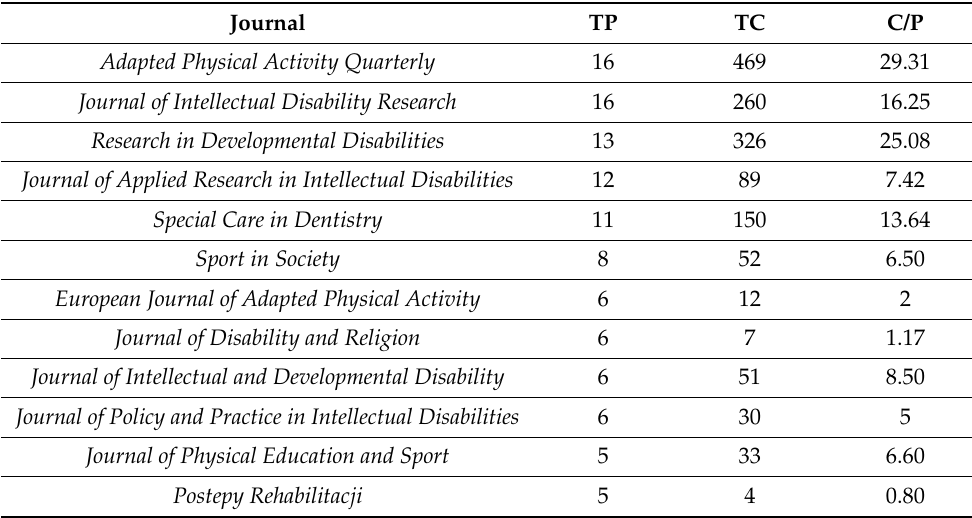
Table 4. Top 10 most prolific Scopus-indexed journals publishing Special Olympics publications between 1978 and 4 March